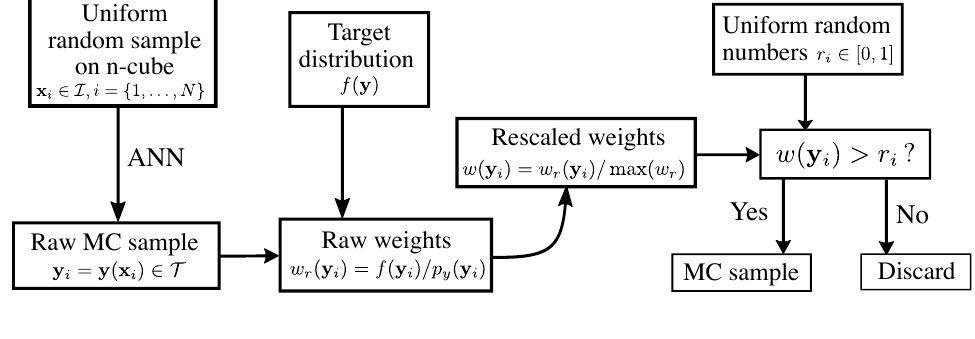
Figure 2: Diagram representing an ANN-based Monte Carlo generator. From Ref. [ 1 ]